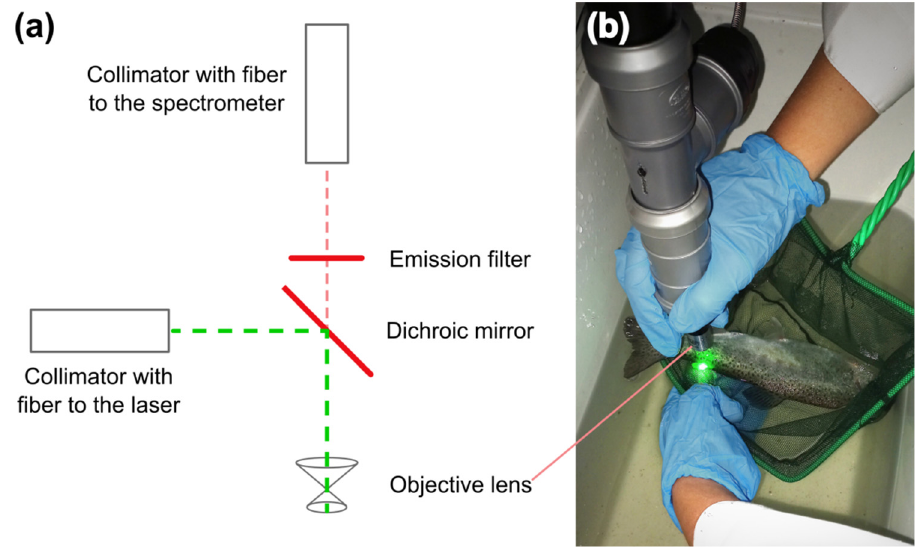
Figure 1. The optical setup (hand ‐ held device) for in vivo pH measurements using implanted sen ‐ sors. ( a ) Optical scheme of the setup. ( b ) Photo of the device during pH measurements on non ‐ anesthetized